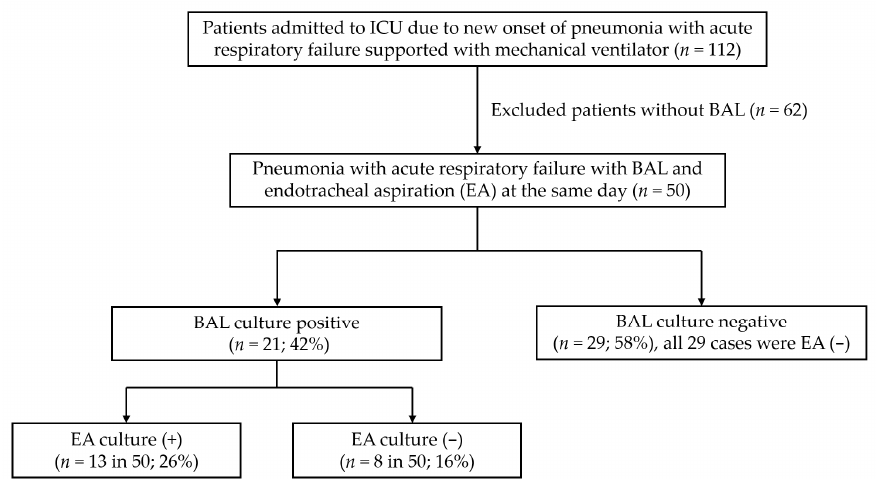
Figure 1. Study flow chart. EA, endotracheal aspiration; BAL, bronchoalveolar lavage.